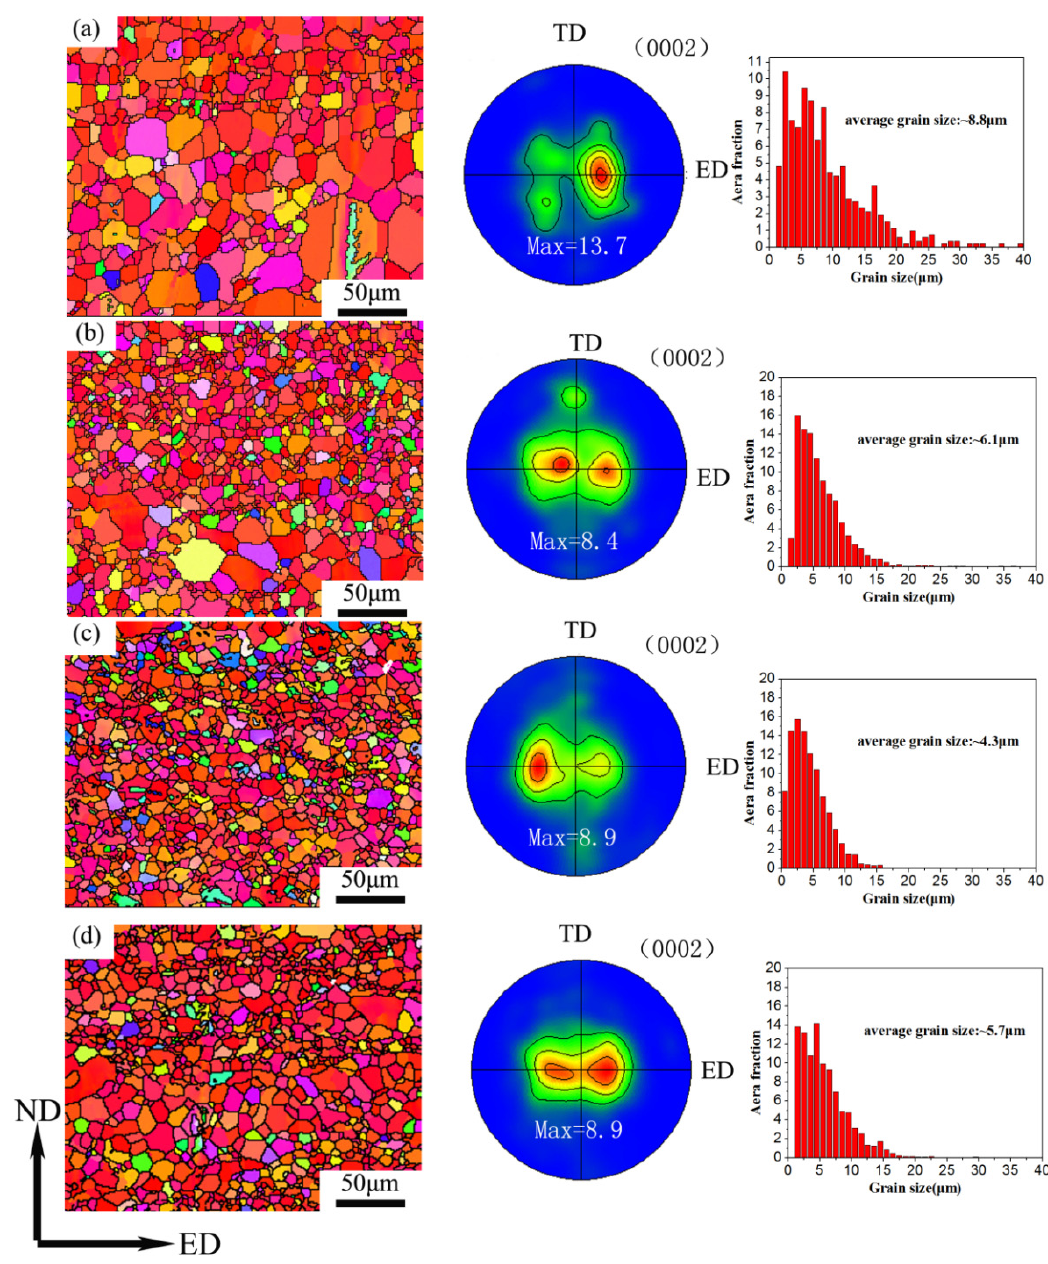
Figure 7. Inverse pole figure, pole figure, and grain size distribution maps of the sheets: ( a ) alloy 1, ( b ) alloy 2, ( c ) alloy 3, and ( d ) alloy 4.